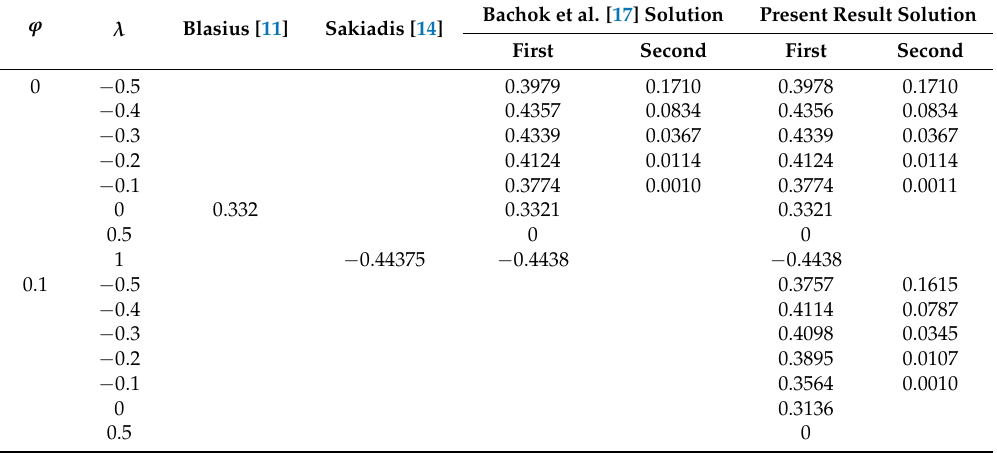
Table 2. Values of f (cid:48)(cid:48) ( 0 ) for selected value of ϕ and λ for water-SWCNT and σ =